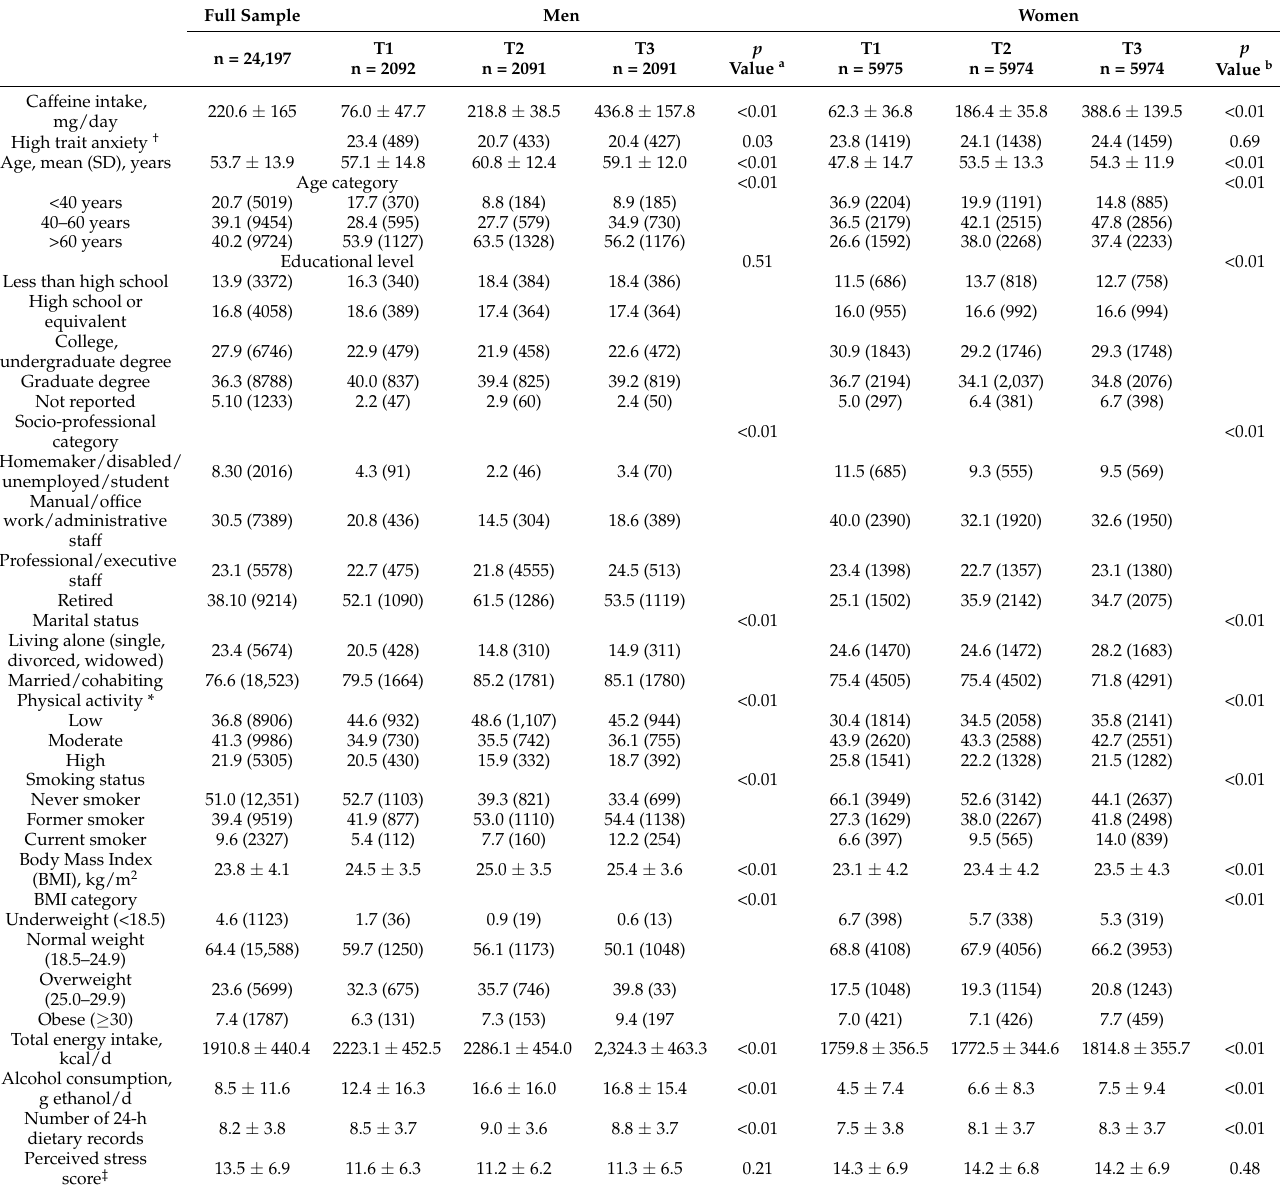
Abbreviations: SD, standard deviation. Data expressed as percentage (number) or mean ± standard deviation, as appropriate. p -values for comparisons between tertiles of caffeine intake for men a and women b were calculated by Pearson’s chi-square test for categorical variables or one-factor ANOVA for continuous variables. † Spielberger Trait Anxiety Inventory (STAI-T) Form Y; score range between 20 and 80 points, with higher scores indicating higher anxiety symptomatology, high trait anxiety STAI–T score in Q4. * Assessed with the International Physical Activity Questionnaire-Short Form; scoring followed established protocol. ‡ Assessed with Cohen’s Perceived Stress Scale-10 (PSS-10) where higher scores indicate higher levels of perceived